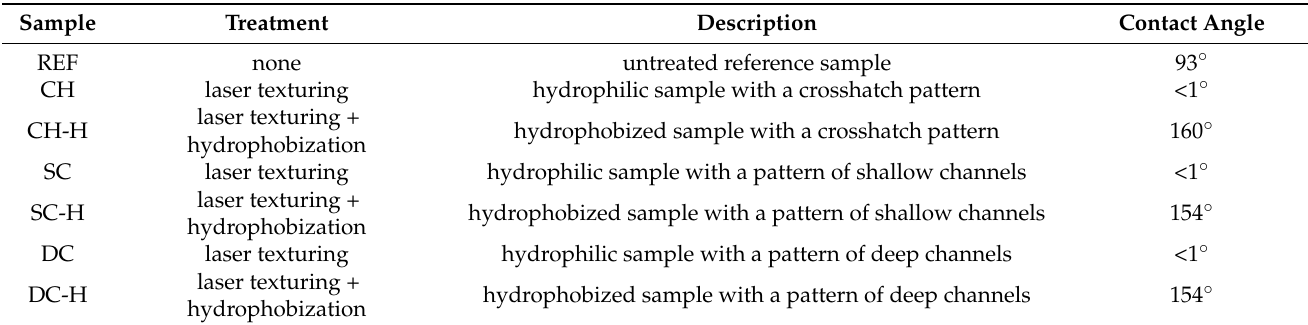
Table 2. List of samples used in the